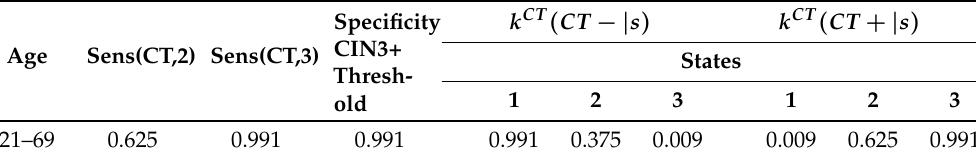
Table A3. Data related to test characteristics and observation